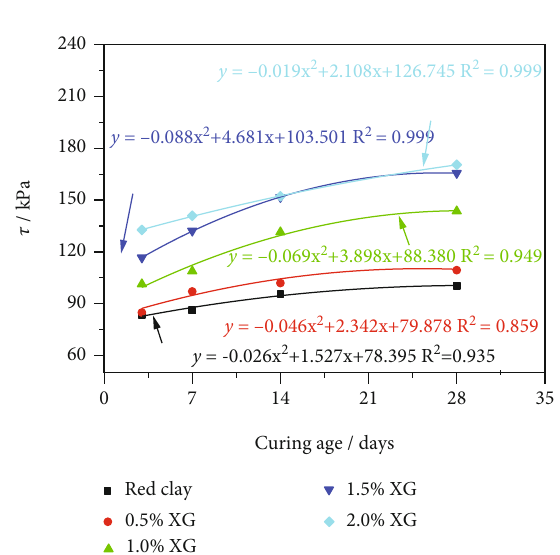
Figure 14: Relationship between curing ages and